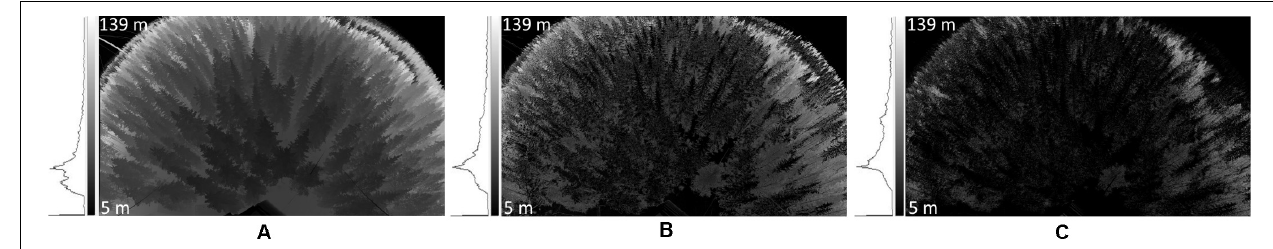
FIGURE 4 | Example of output raster images colorized in gray scale by range from Hyytiälä test area acquired on May 11, 2020, in which (A–C) show the image layers from first to the third return. The histograms on the left side of each subfigure show the range distribution of detected